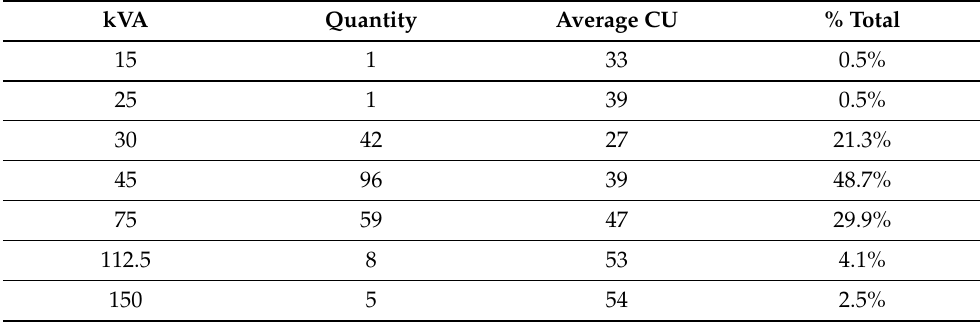
Table 3. List of transformers for Feeder